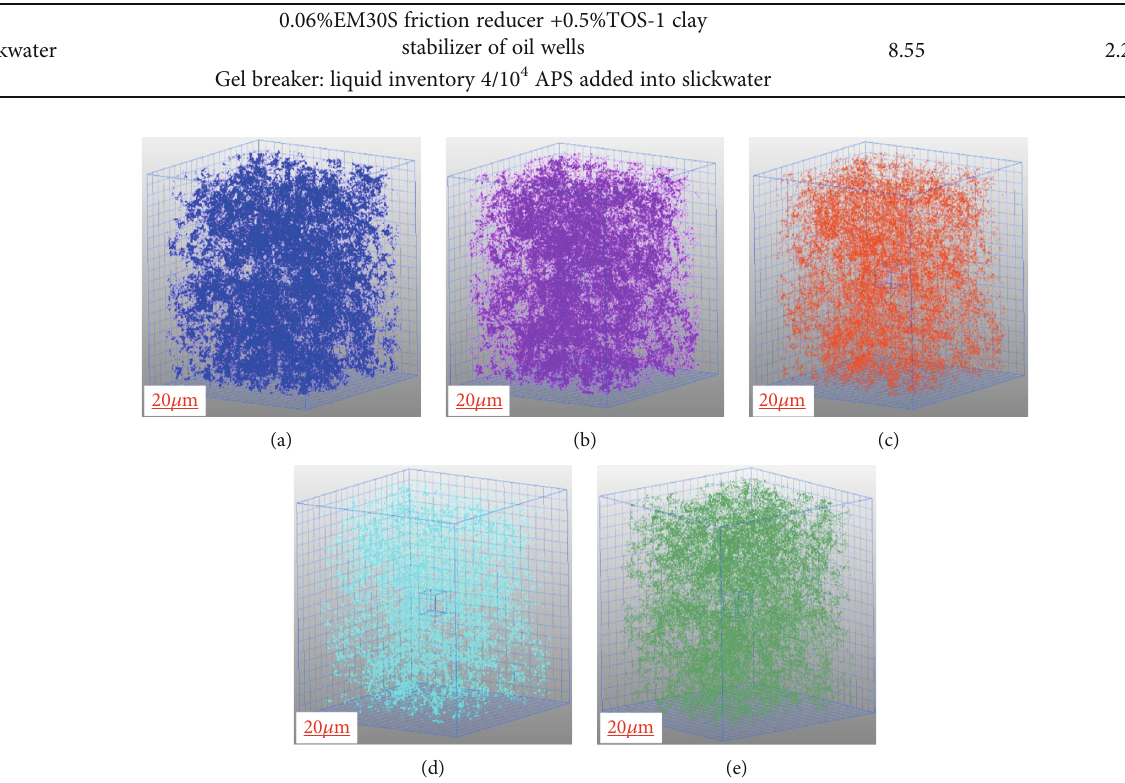
Figure 2: Variations in the pore volume of cores at di ff erent times (Note: (a) snapshot after saturation with formation water; (b) 9h after fracturing fl uid invasion; (c) 24h after fracturing fl uid invasion; (d) 72h after fracturing fl uid invasion; (e) 24h after subsequent water fl ooding). Table 2: Statistics of pore volume and number of pores in the core at di ff erent times.